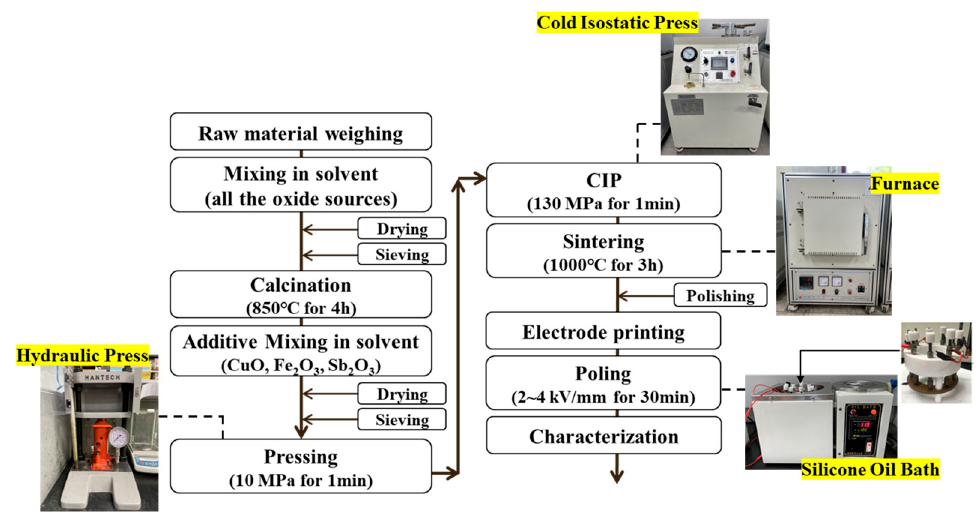
Figure 1. Process flow diagram describing fabrication of PZN-PMN-PZT ceramics.